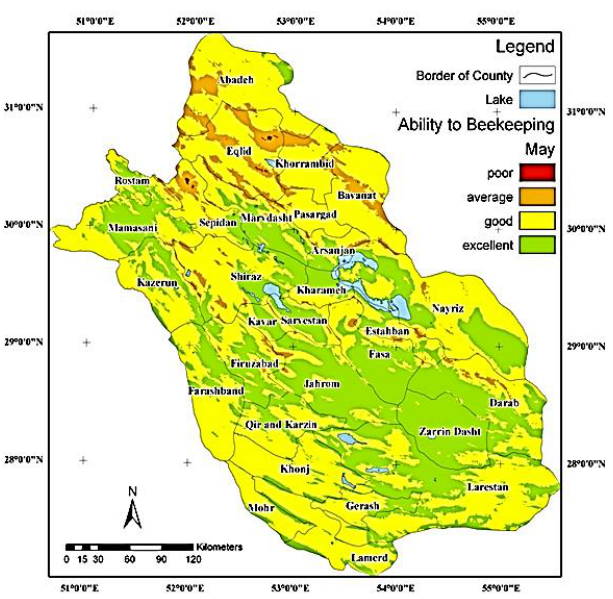
Fig. 2. Suitability of climate conditions for beekeeping in